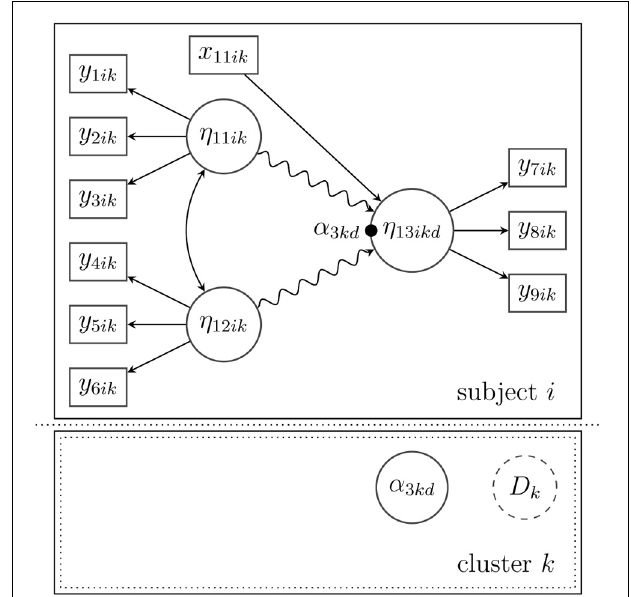
FIGURE 3 | Structural model for subject i in latent class C ik with a nonlinear spline relationship between the latent variables (indicated by the snake-type arrow). Note that this figure shows only a single-level model; the index d is therefore omitted.